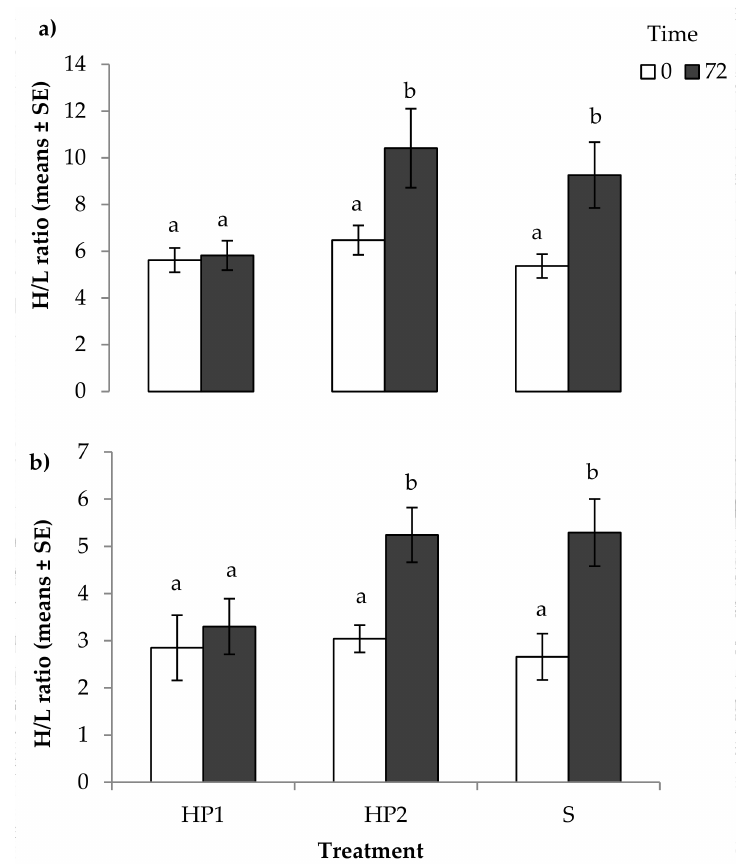
Figure 4. Mean heterophil/lymphocyte (H/L) ratios of the interaction between husbandry treatment and sampling time as a measure of acute stress responses of 7.5-month-old ostriches exposed to husbandry treatments that differed in the extent of human presence and interactions with the birds before and 72 h after: ( a ) feather harvesting ( N = 238); ( b ) feather clipping ( N = 87). For feather harvesting: the birds in Human Presence 1 treatment (HP1, N = 74) were exposed to extensive/prolonged human presence with physical contact (touch, stroking), gentle human voice, and visual contact. The birds in HP2 treatment ( N = 87) were exposed to extensive human presence with gentle human voice and visual contact, but without physical contact. The birds in S treatment ( N = 77) had human presence and visual human contact limited to the provision of food and fresh water. For feather clipping: HP1 treatment ( N = 28), HP2 treatment ( N = 29), S treatment (30). Means with different superscripts differed significantly ( p <